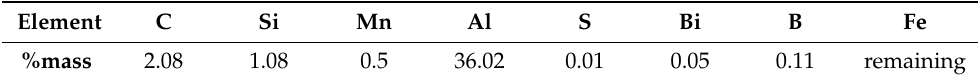
Table 4. Chemical composition of high-aluminum cast